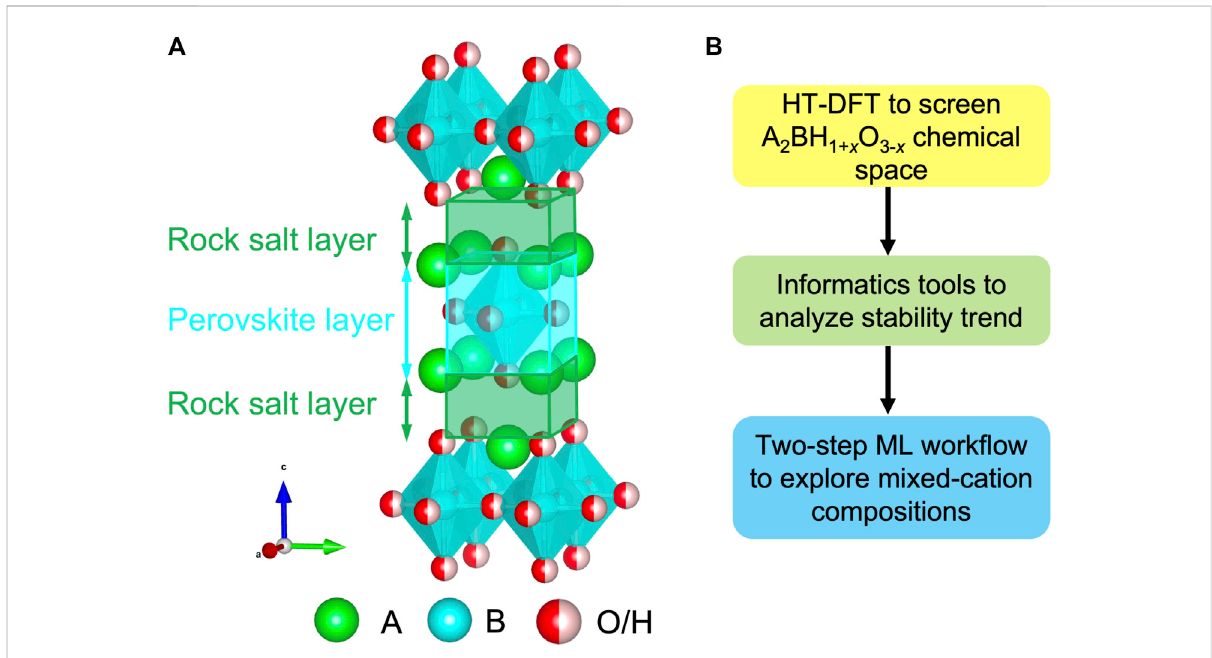
FIGURE 1 (A) Crystal structure of the A 2 BH 1+ x O 3- x ( x = 0, 1, 2) oxyhydrides in the K 2 NiF 4 -type framework. (B) Computational work fl ow to study the chemistry of the